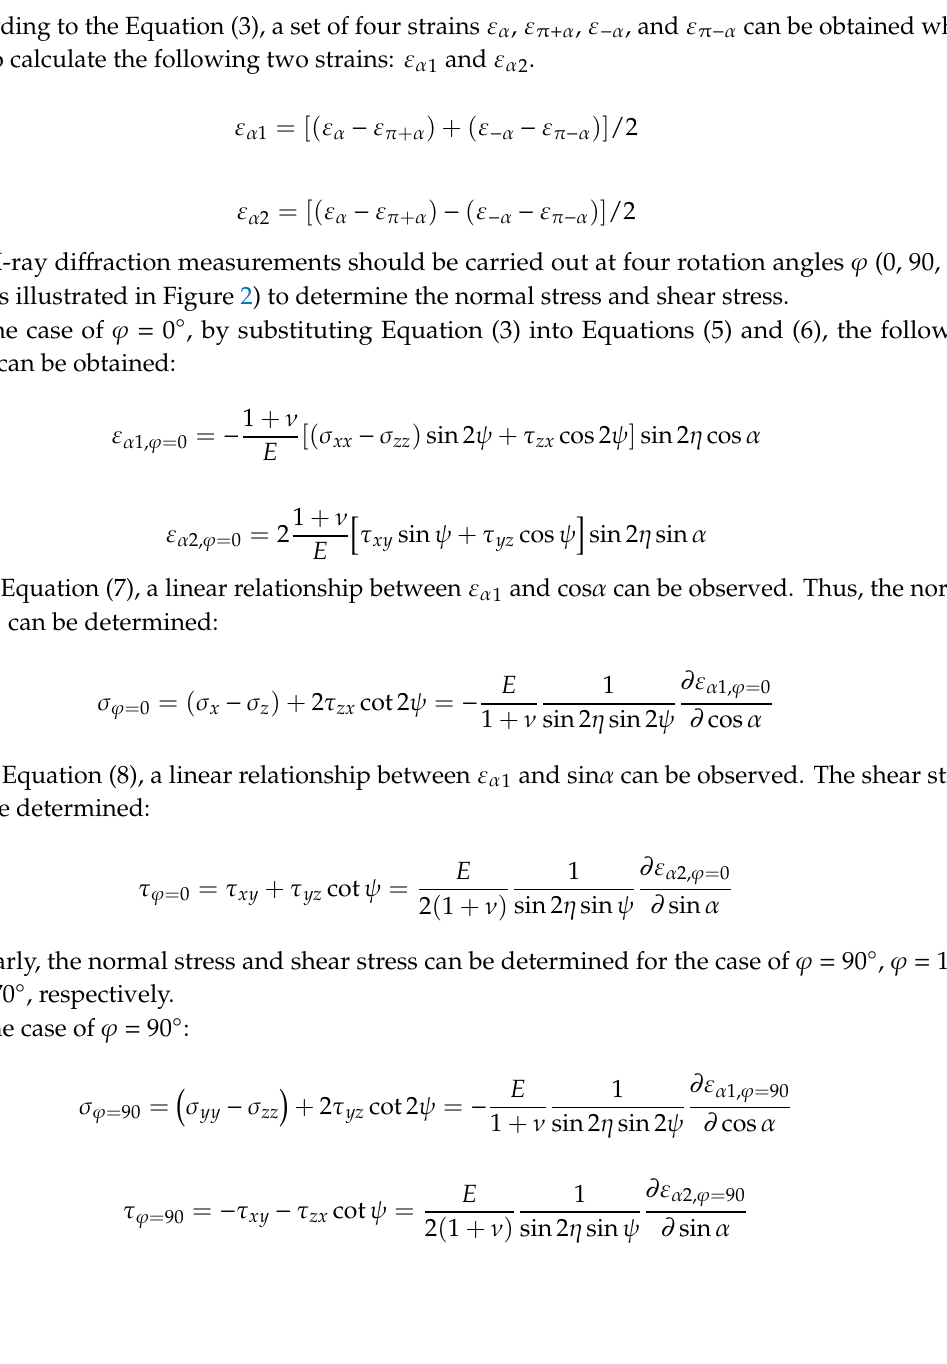
Figure 2. Residual stress determination by using cos α method.